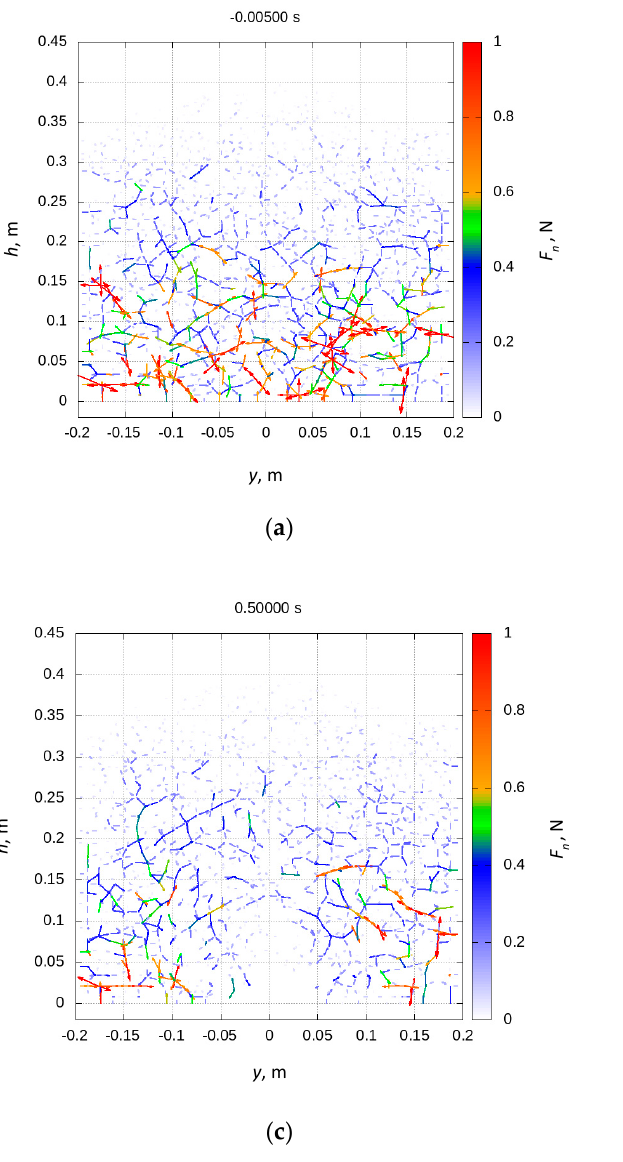
Figure 9. Network of interparticle normal (left column) and tangential (right column) forces at the cross-section of the bedding for D 0 = 0.056 m at discharge time of 0.3 s ( a , b ) and 0.58 s ( c , d ).